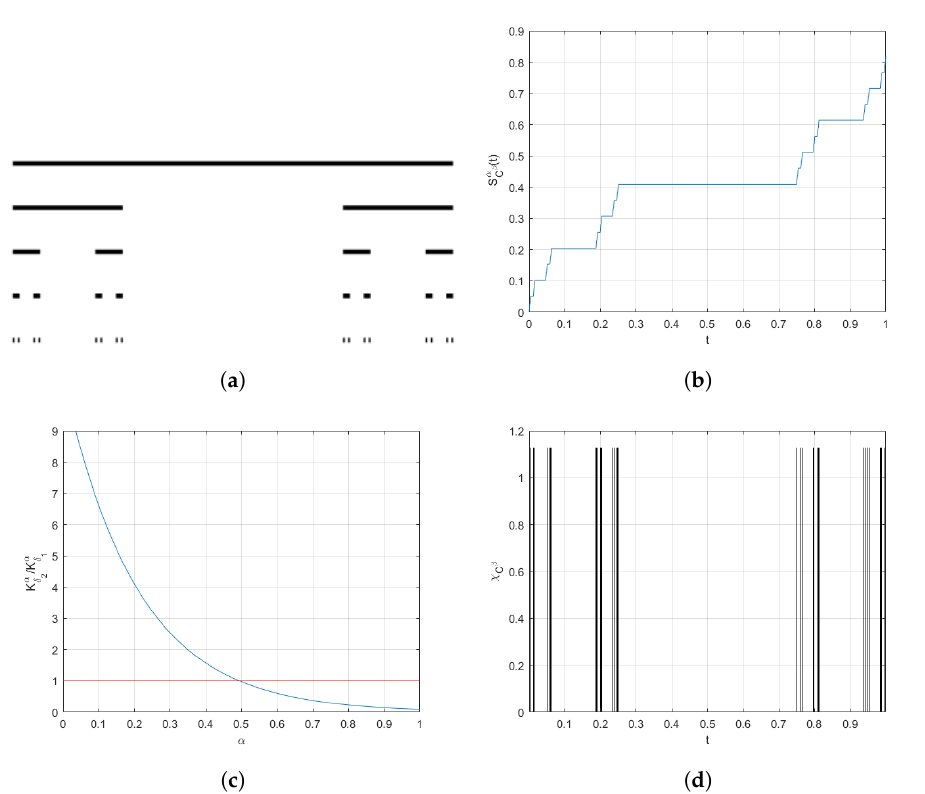
Figure 1. Figures for Section 2. ( a ) The thin Cantor-like set with β = 2; ( b ) staircase function corresponding to the thin Cantor-like set with β = 2; ( c ) the γ -dimension is α = 0.5 for the thin Cantor-like set with β = 2; ( d ) fractal characteristic function for the thin Cantor-like set with β =